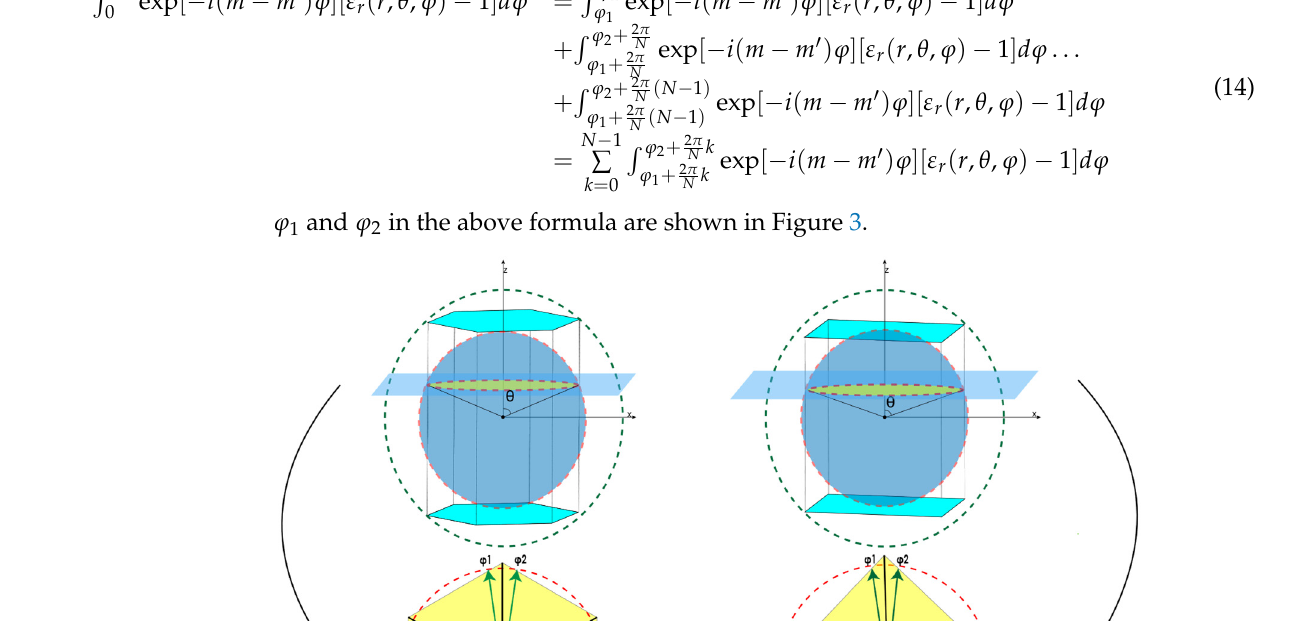
Figure 3. Particles with N-fold symmetric geometry cross section. (for the particles with N-fold symmetric geometry, ϕ r = 2 π / N ), θ is the zenith angle. ϕ 1 , ϕ 2 is the azimuth of the intersection point in [ − ϕ r /2, ϕ r /2 ]